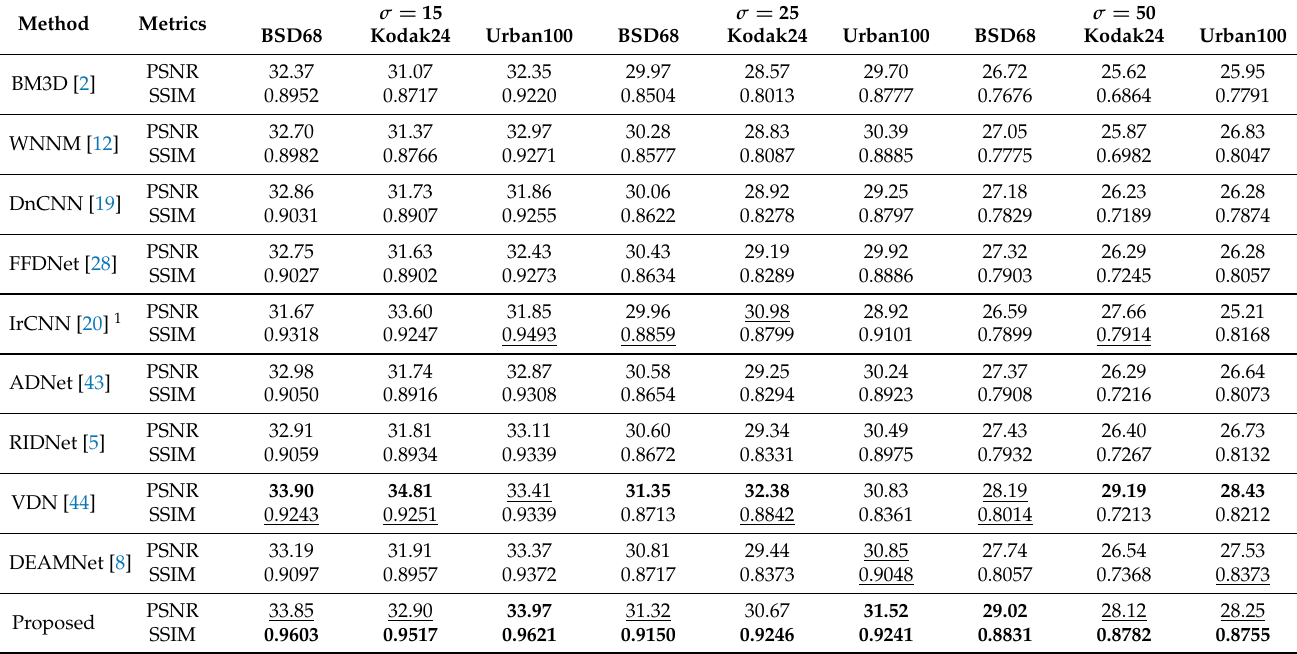
Table 1. Quantitative comparison results of the competing methods with AWGN noise levels σ = 15, 25, 50 on kodak24, BSD68, and Urban100. Top results are in bold, and second-best results are